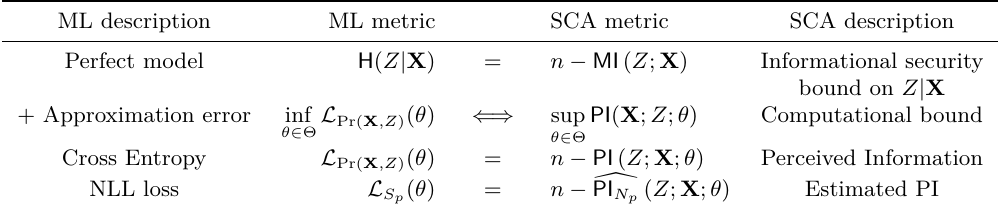
Table 1: machine learning metrics and their meaning in Side-Channel